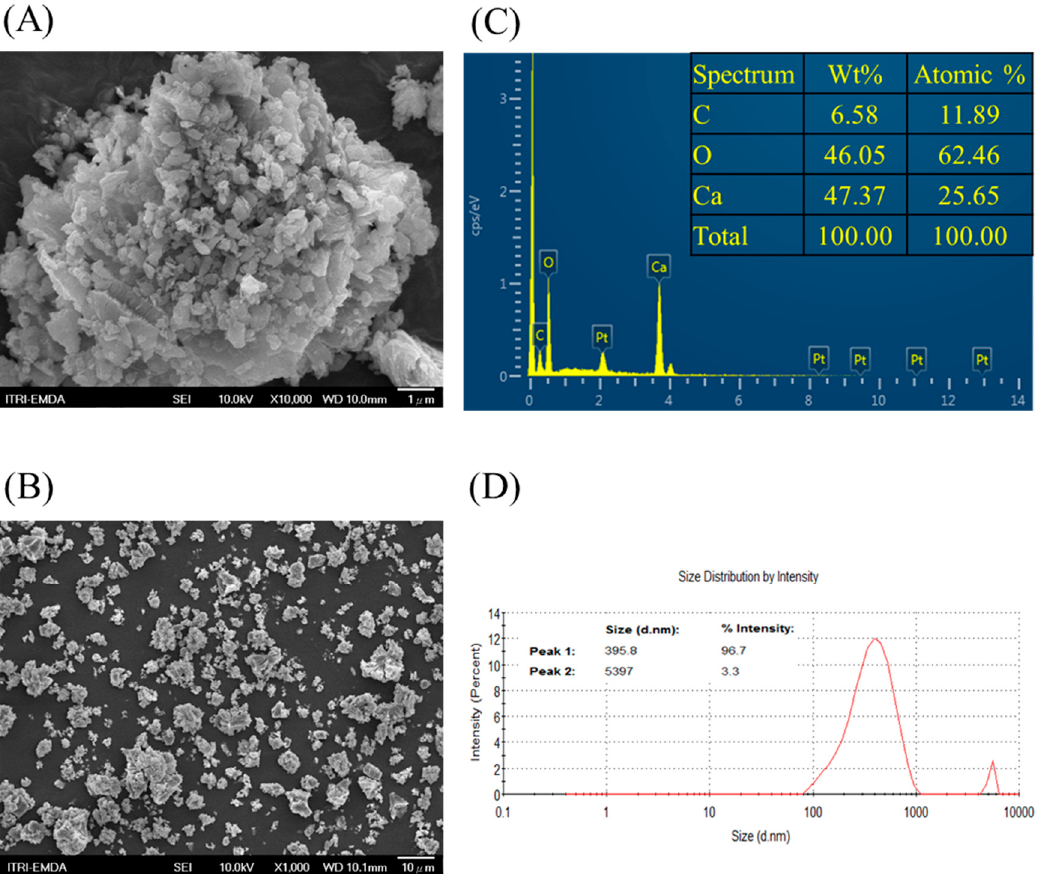
Figure 1. Scanning electron microscope (SEM) image of calcined waste mussel shell (CCS) at 10,000× ( A ) and 1000× ( B ) magnification, as well as energy-dispersive spectroscopy (EDS) spectrum ( C ) and particle size distribution ( D ) of CCS.